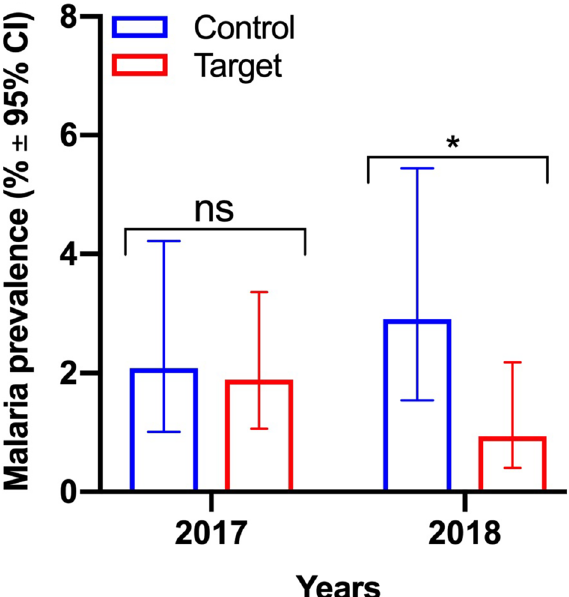
Figure 4. Malaria prevalence in the target and control villages of Anopheles reproductive swarm trapping. The target villages are: Chamoi, Dampha kunda, Tambasansang and Madina Yoro; and control ones are: Bakadagy and Mamasutu. The bars corresponds to the malaria prevalence ± 95% Confident Interval in 2017 and 2018. The significance of the difference is indicated (ns, p > 0.05; *p < 0.05).